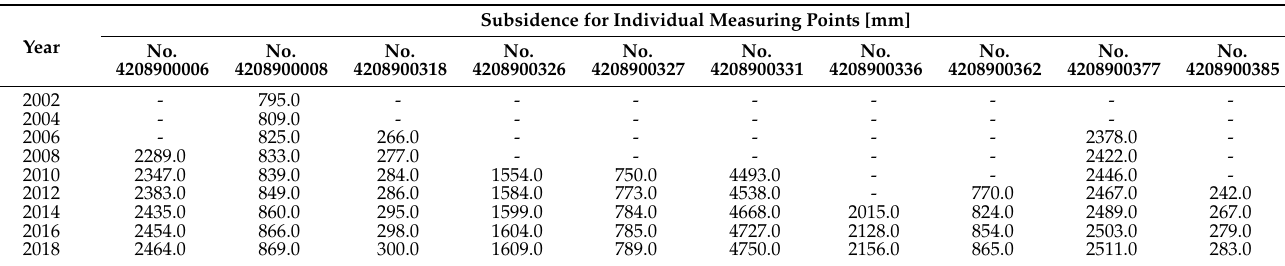
proprietary method. Table 3 shows the values of measured subsidence of measurement points in the last measurement cycles until 2018. Table 3. The values of the measured subsidence of measurement points 4208900006–4208900327 in the individual periods of time from the moment when exploitation ceased in the individual areas. Year